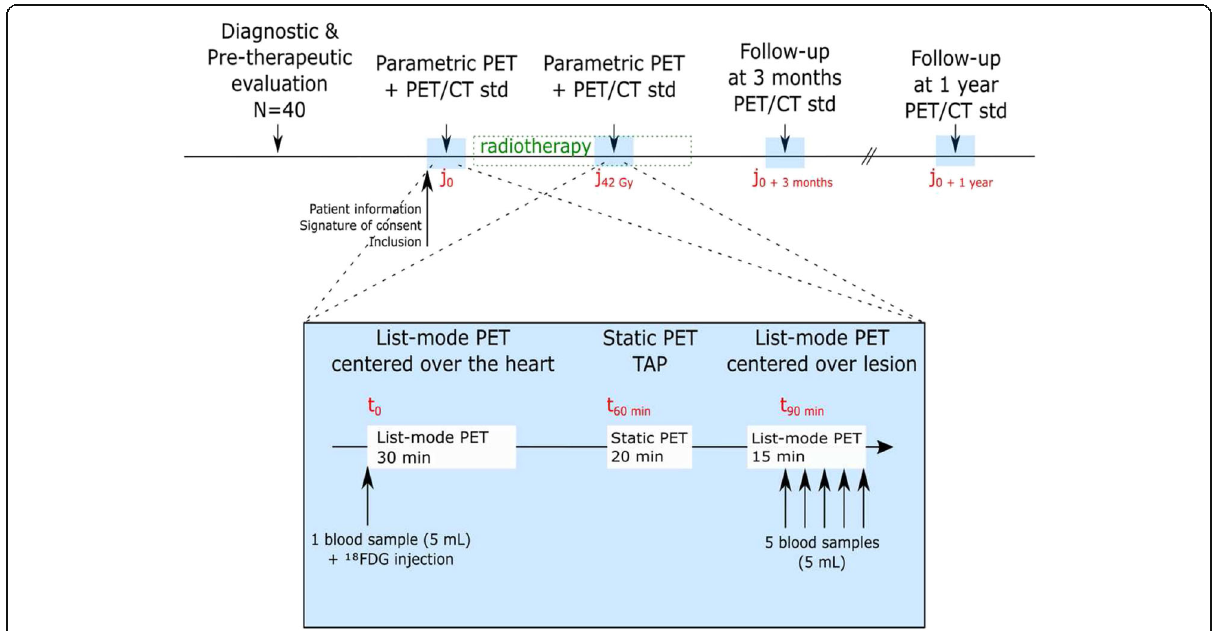
Fig. 3 ParaPET clinical trial design. All patients benefit from two parametric acquisition sequences, one before and one at 42 Gy of their